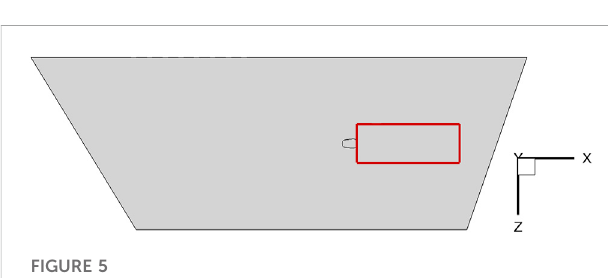
FIGURE 5 Computational domain after coordinate transformation and